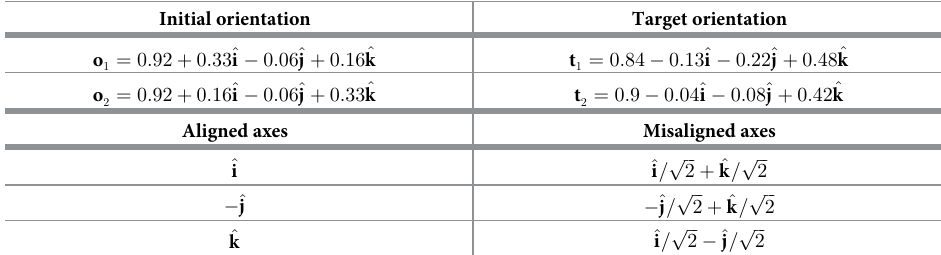
Table 1. Initial cursor and target orientations and rotation